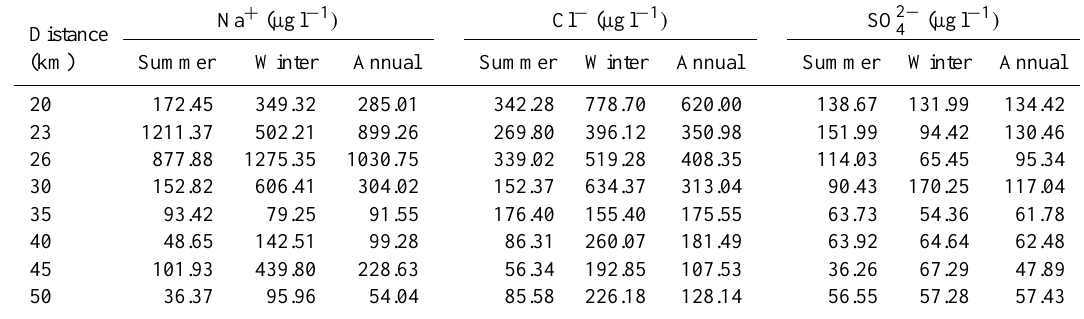
in snow from the steep escarpment of the transect. 4